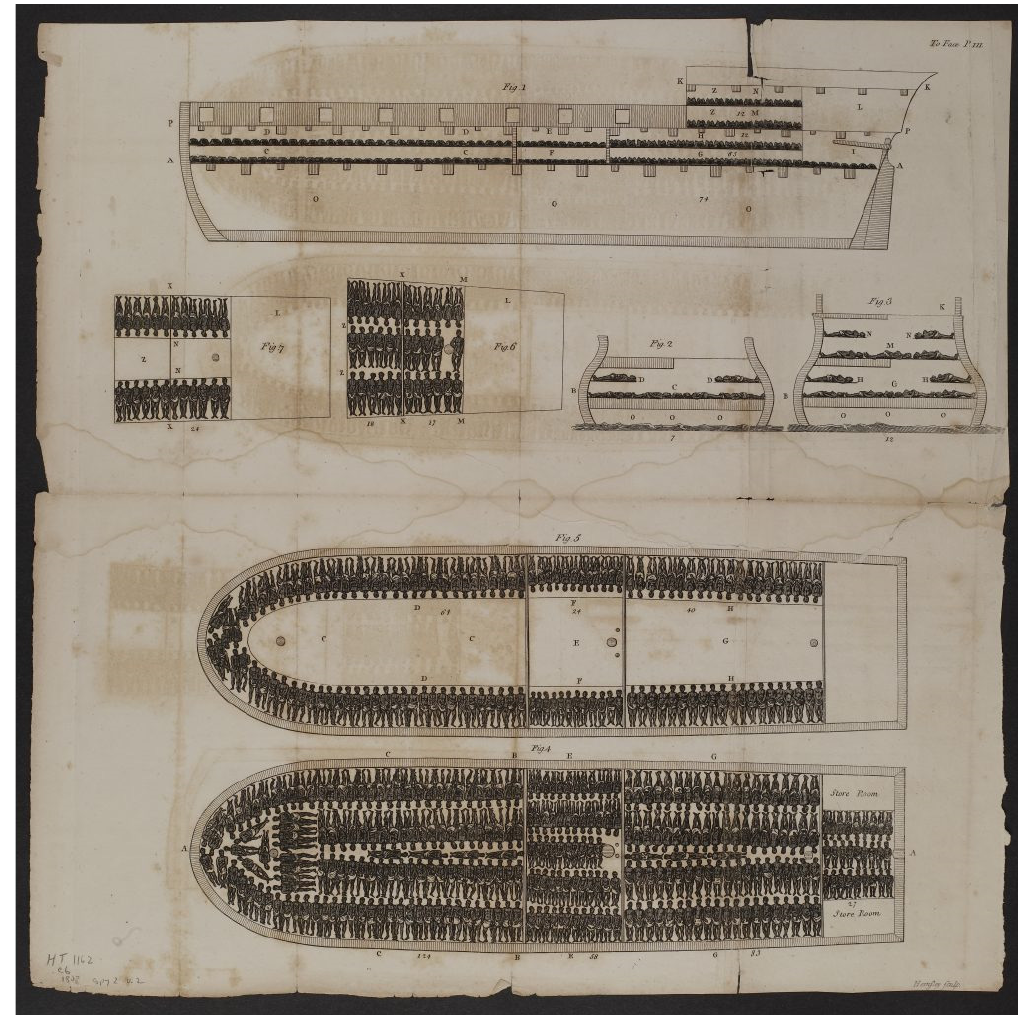
Figure 1. Clarkson, Thomas. The History of the Rise, Progress, and Accomplishment of the Abolition of the African Slave-Trade by the British Parliament. London: Longman & Co. 1808. Print. Describing the physical hierarchy coded in the plans, Smallwood connects this vertical expression of the vessel construction to the hierarchy of power instated by enslavers during the crossing. From the plans, she teases out evidence of a prescribed degree of